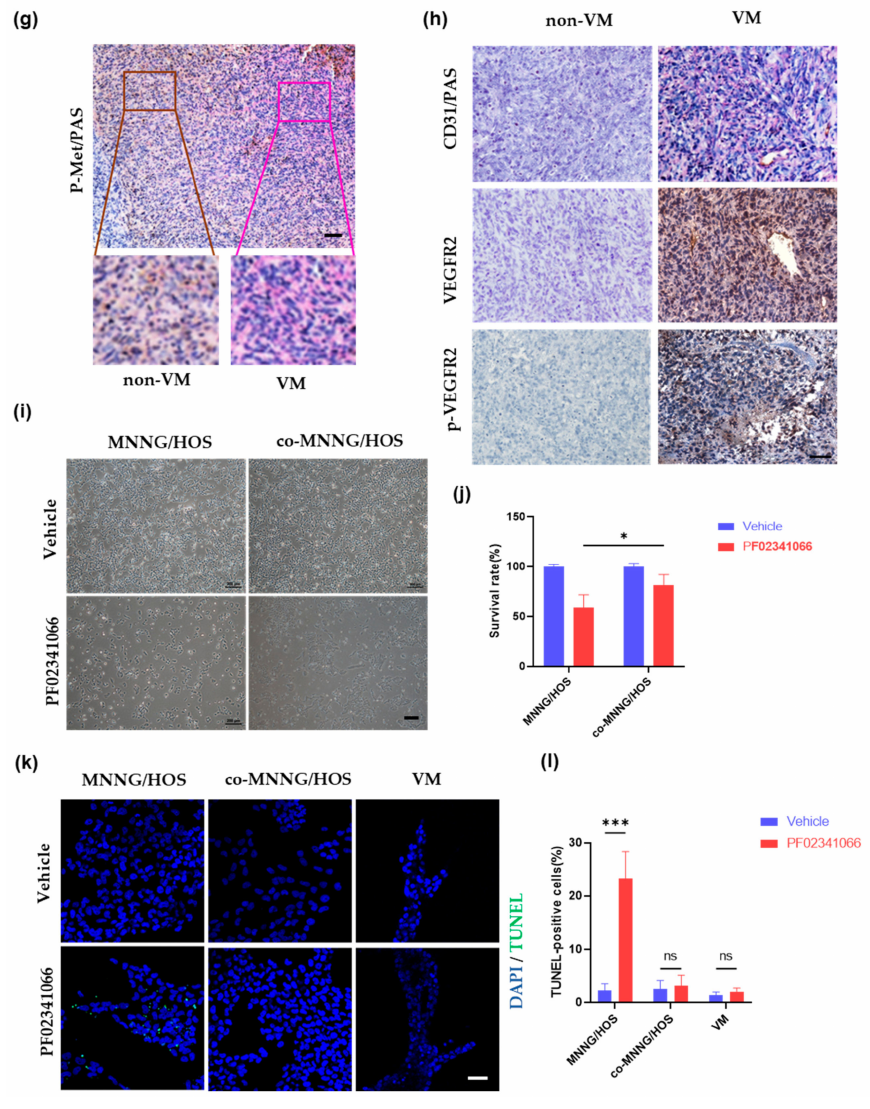
Figure 4. The vascular niche could promote drug resistance to PF02341066 treatment by reducing c-Met activation in MNNG/HOS cells. ( a – d ) Statistical analysis indicated the area of vessels ( a , b ) and necrosis ( c , d ) from xenograft tissues in the vehicle and PF02341066 group on day 20. Mean ± SEM, n = 3. ** p < 0.01 by two-tailed Student’s t -test. Scale bar = 50 µ m. ( e , f ) IHC staining on c-Met and VEGFR2 phosphorylation of xenograft tissues from mice on day 20 after vehicle or PF02341066 treatment. NuMA staining indicated human-derived MNNG/HOS cells. CD31 staining indicated tumor vessels. Scale bar = 50 µ m. Quantitative analysis of the expression of p-Met and p-VEGFR2. Mean ± SEM, five independent samples, each with n = 5. ** p < 0.01 by two-tailed Student’s t -test. ( g ) p-Met-PAS double staining of xenograft tissues from mice on day 20. Violet staining of PAS represented VM. Scale bar = 50 µ m. ( h ) PAS and VEGFR2 or p-VEGFR2 staining of xenograft tissues from mice on day 20. Violet staining of PAS represented VM. Scale bar = 50 µ m. ( i , j ) Respective bright- field microscopy images ( i ) and statistical analysis ( j ) showing MNNG/HOS and co-MNNG/HOS living cells after being treated with 0.05 µ M PF02341066 for 48 h. Scale bar = 200 µ m. Mean ± SD, n = 3. * p < 0.05 by two-tailed Student’s t -test. ( k , l ) Respective images. Scale bar = 50 µ m. ( k ) and quantitative analysis ( l ) of TUNEL apoptosis assay on MNNG/HOS cells, co-MNNG/HOS cells and MNNG/HOS-VM after being treated with 0.05 µ M PF02341066 for 48 h. Mean ± SEM, three independent experiments, each with n = 3. *** p < 0.001, ns p > 0.05 by two-way